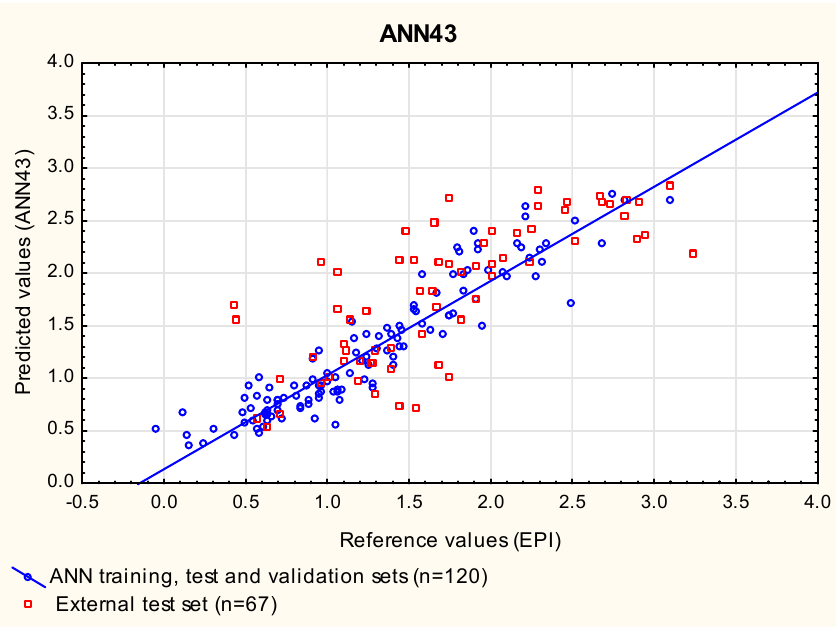
Figure 7. ANN43 model—predicted vs. reference log BCF values .